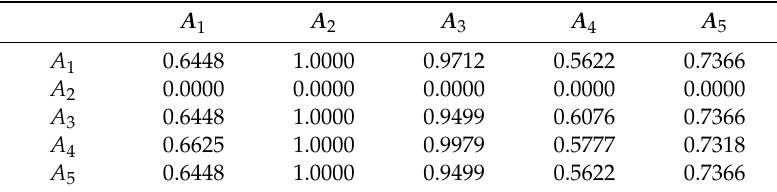
Table 11. Transformed probability of the alternative A 2 to A k .